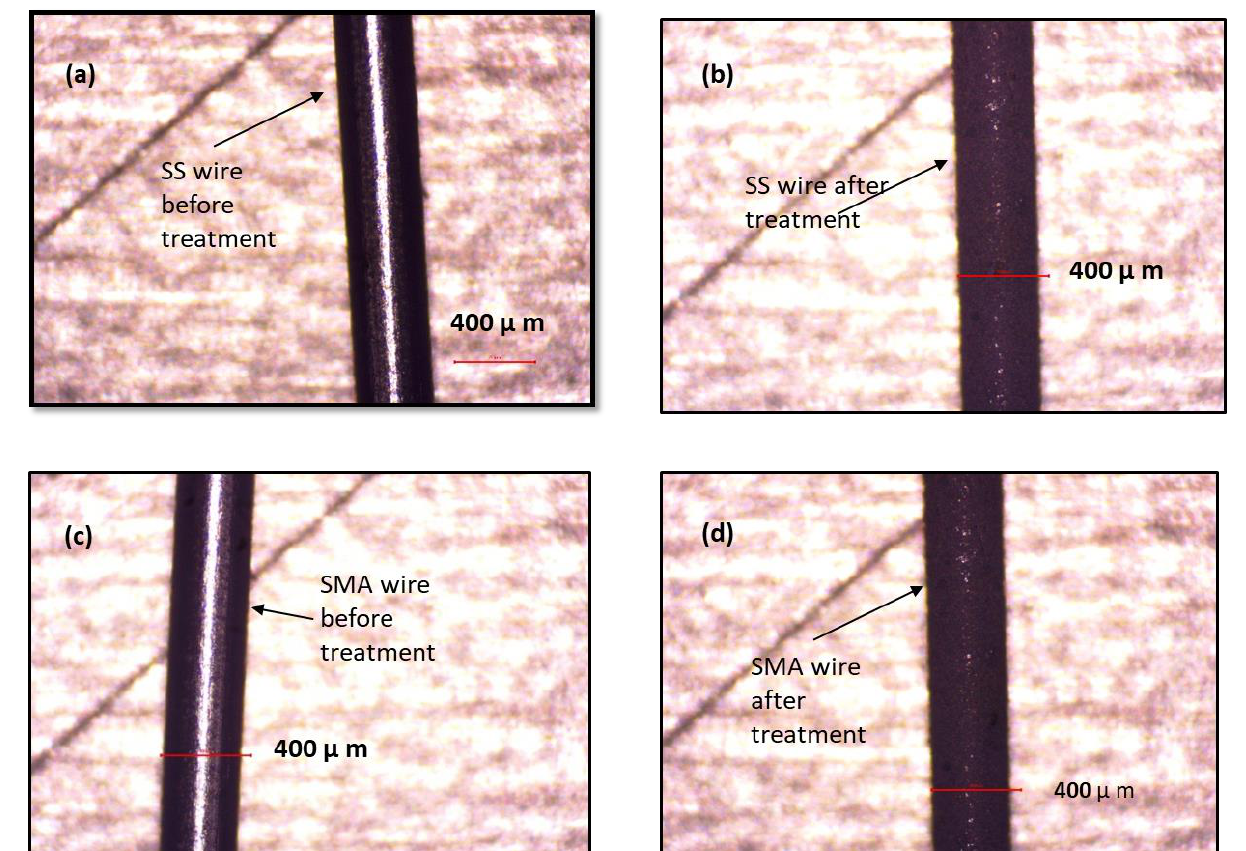
Figure 6. Optical micrographs of ( a ) untreated SS wire surface, ( b ) mechanically treated and ultra- sonicated SS wire surface, ( c ) untreated SMA wire surface, and ( d ) mechanically treated and ultra- sonicated wire surface.